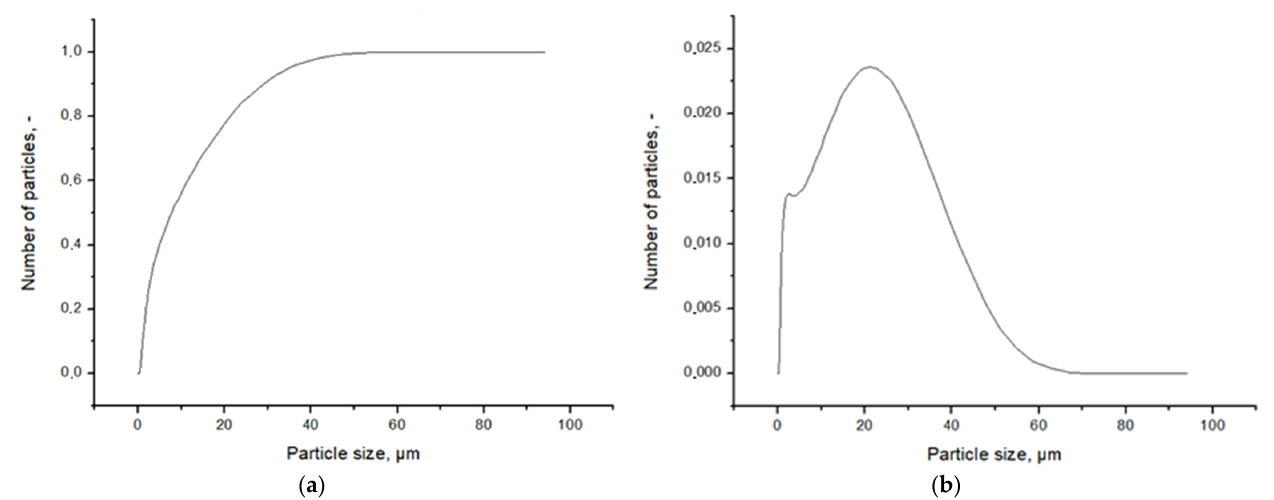
Figure 3. Results of granulometric analysis, ( a ) integral curve, ( b ) differential curve.